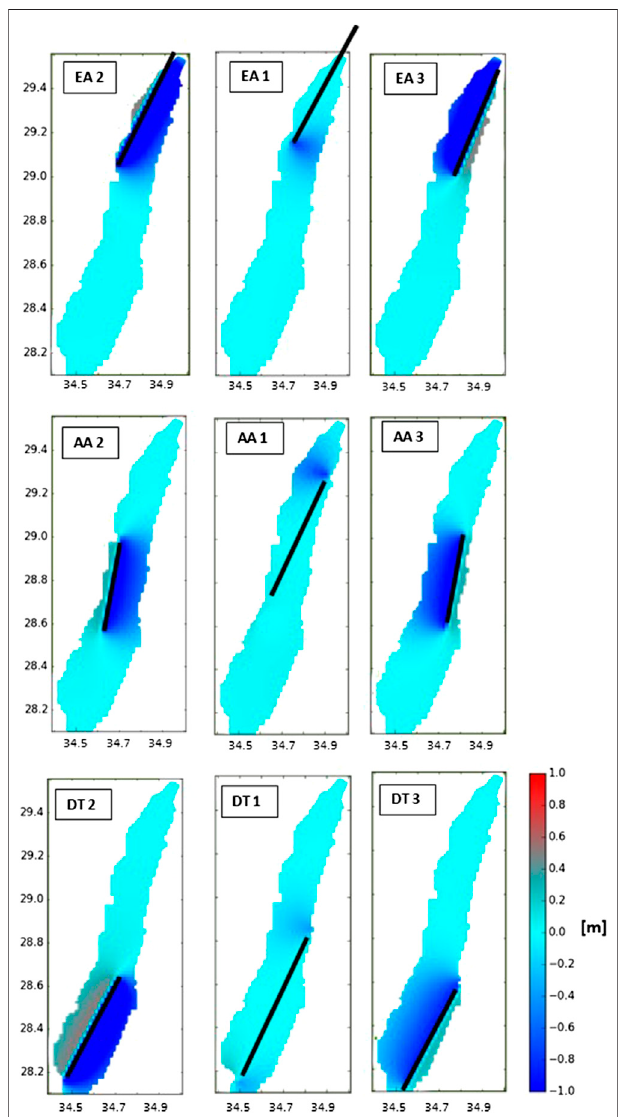
FIGURE 4 | Snapshots of the simulated scenarios that were taken 1 s into the event represent the shape of the water surface induced by the coseismic deformation at the initial stage of the tsunami. See Earthquakes for detailed explanation and Table 1 for earthquake source parameters. Blacklinesdenotethesimulatedfaults;EA,Elat-AqabaBasin;AA,Aragonese- ArnonaBasin;DT,Dakar-TiranBasin.Annotations1,2,and3refertothemain segment of the transform, and the western and eastern margin faults of the given basin, respectively. See Figure 1 for the locations of these maps.